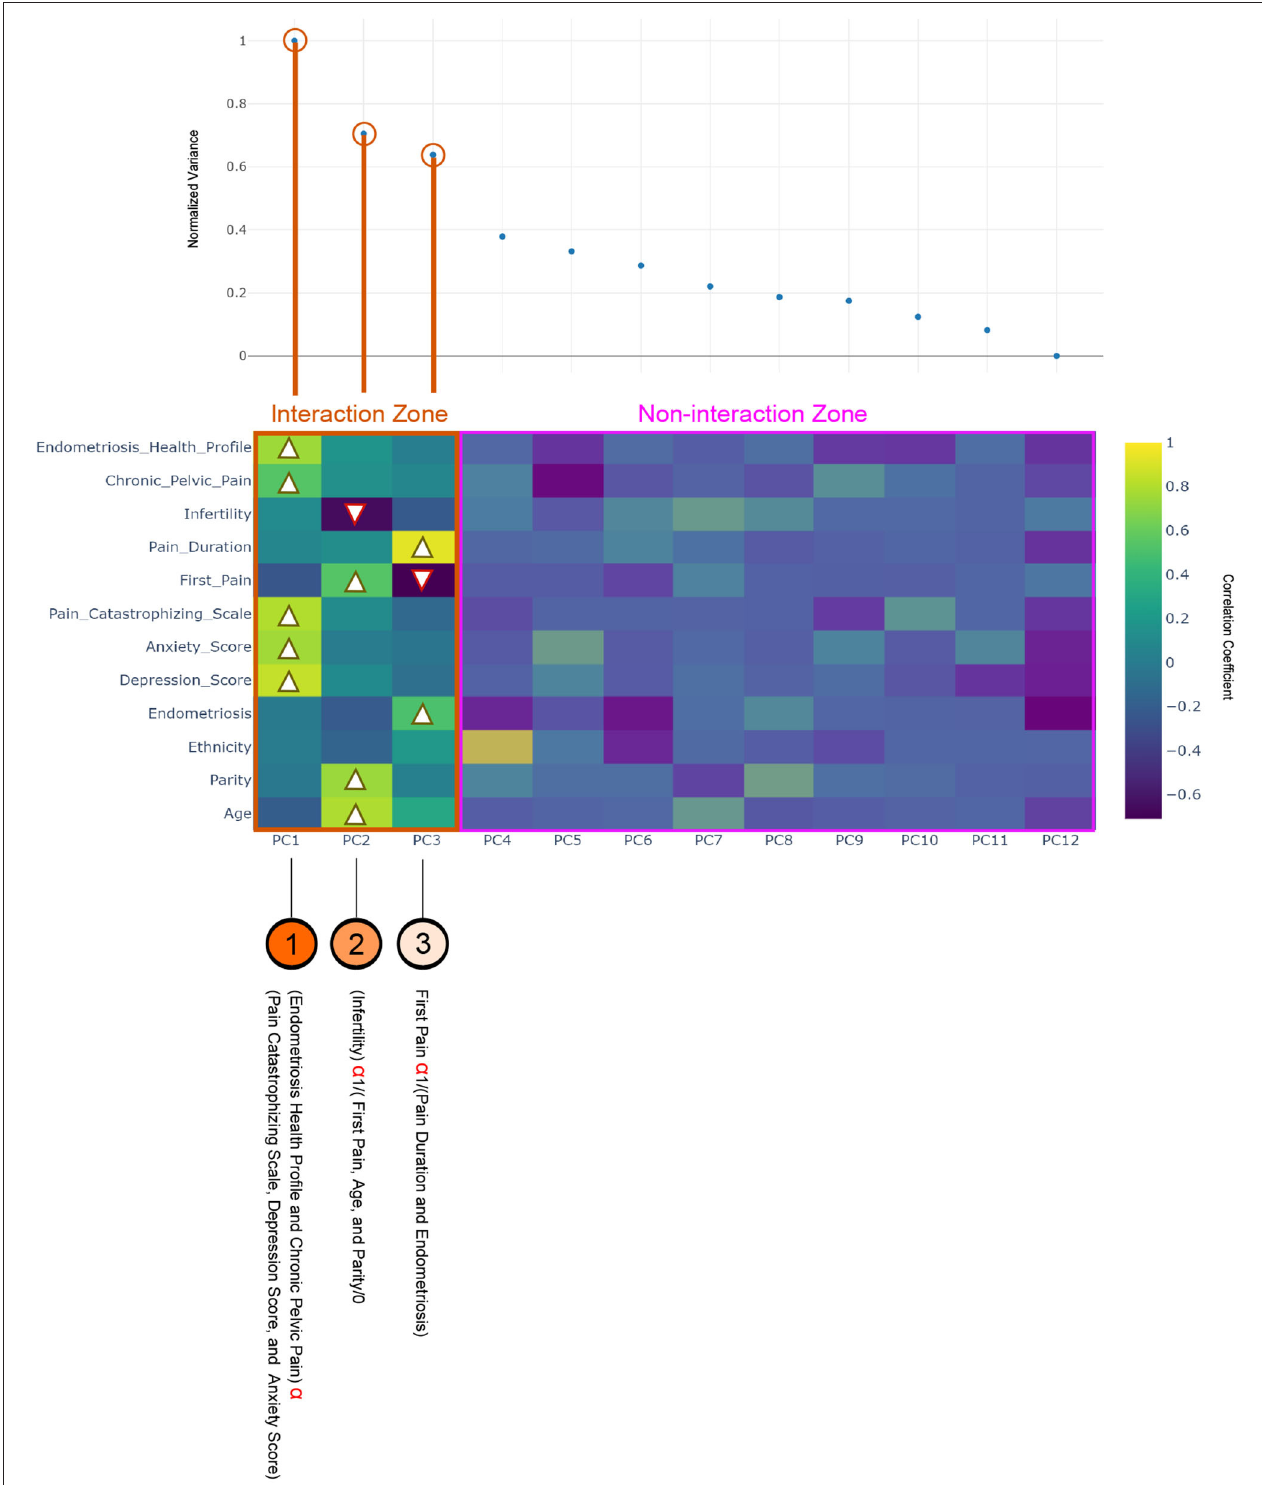
FIGURE 3 | Heat map of the interaction principle component analysis (IPCA) between 12 factors using the Pelvic Pain and Endometriosis database, and the black arrow indicates the direction of the correlation. The interaction zone refers to the number of principle components (PCs) where two or more factors are correlated, while the non-interaction zone refers to the number of PCs that have only single factor that is not correlated with any other factors.